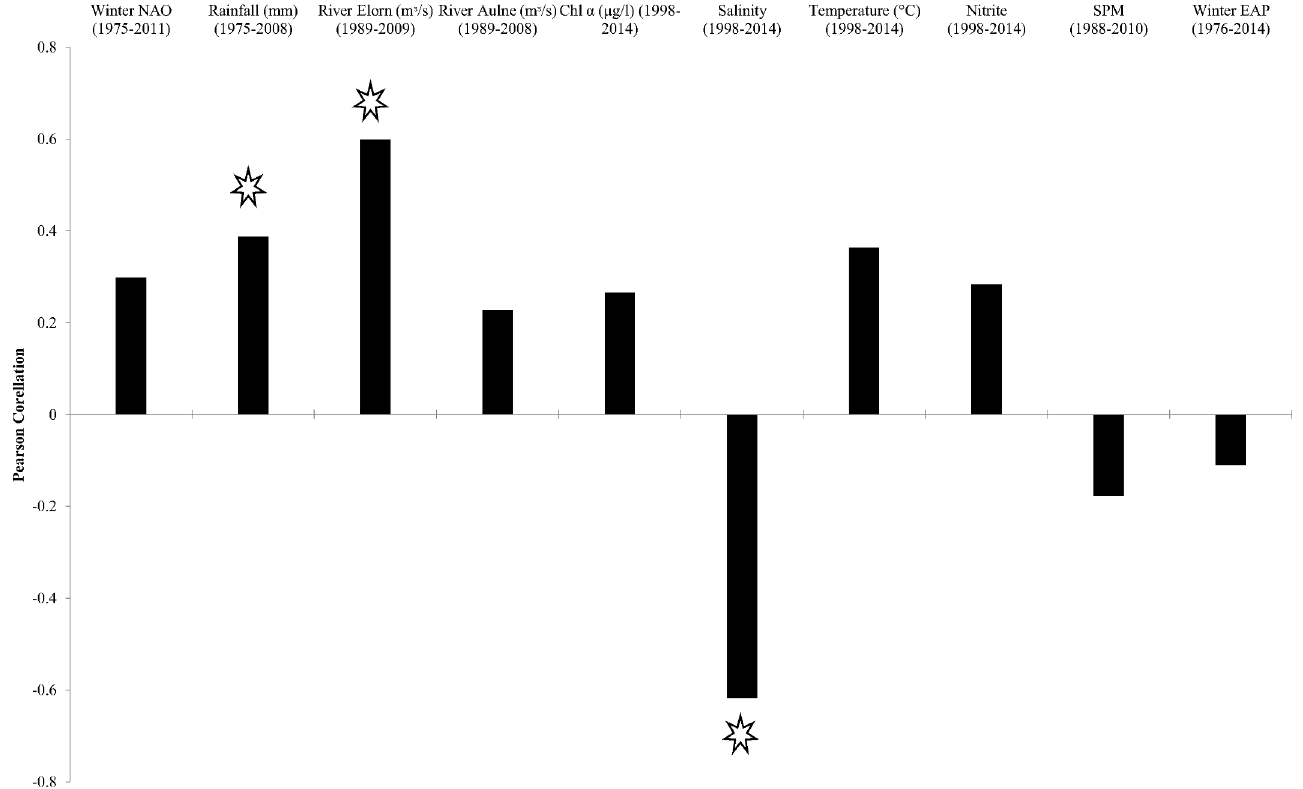
Fig 4. Pearson correlation coefficients of annually averagedenvironmental data with SGI. Significant correlations(p < 0.05) are marked with a star.